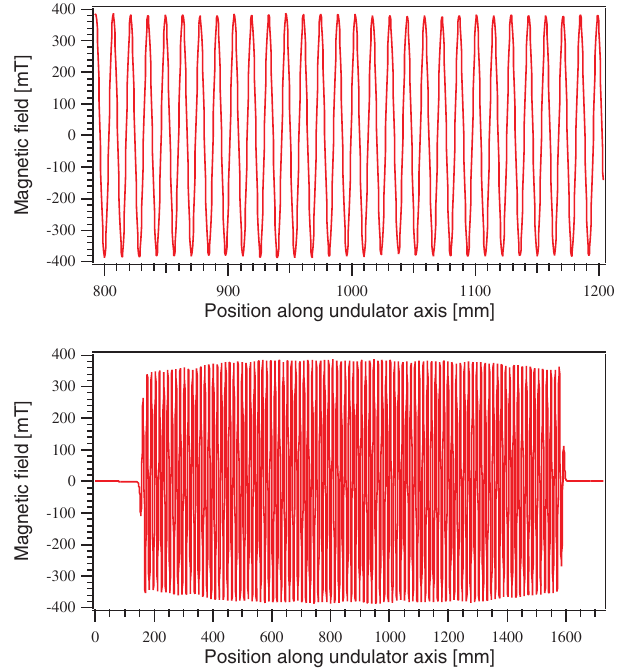
FIG. 2. (Color) (a) Example of the field measured (several periods are selected out of 100). Gap width 8 mm, current density 500 A = mm 2 . (b) The field of the full 100 periods. The coils were bent by 250 (cid:4) m when welded into the cryostat. In the future this welding process will be replaced by a different fixation in order to avoid this